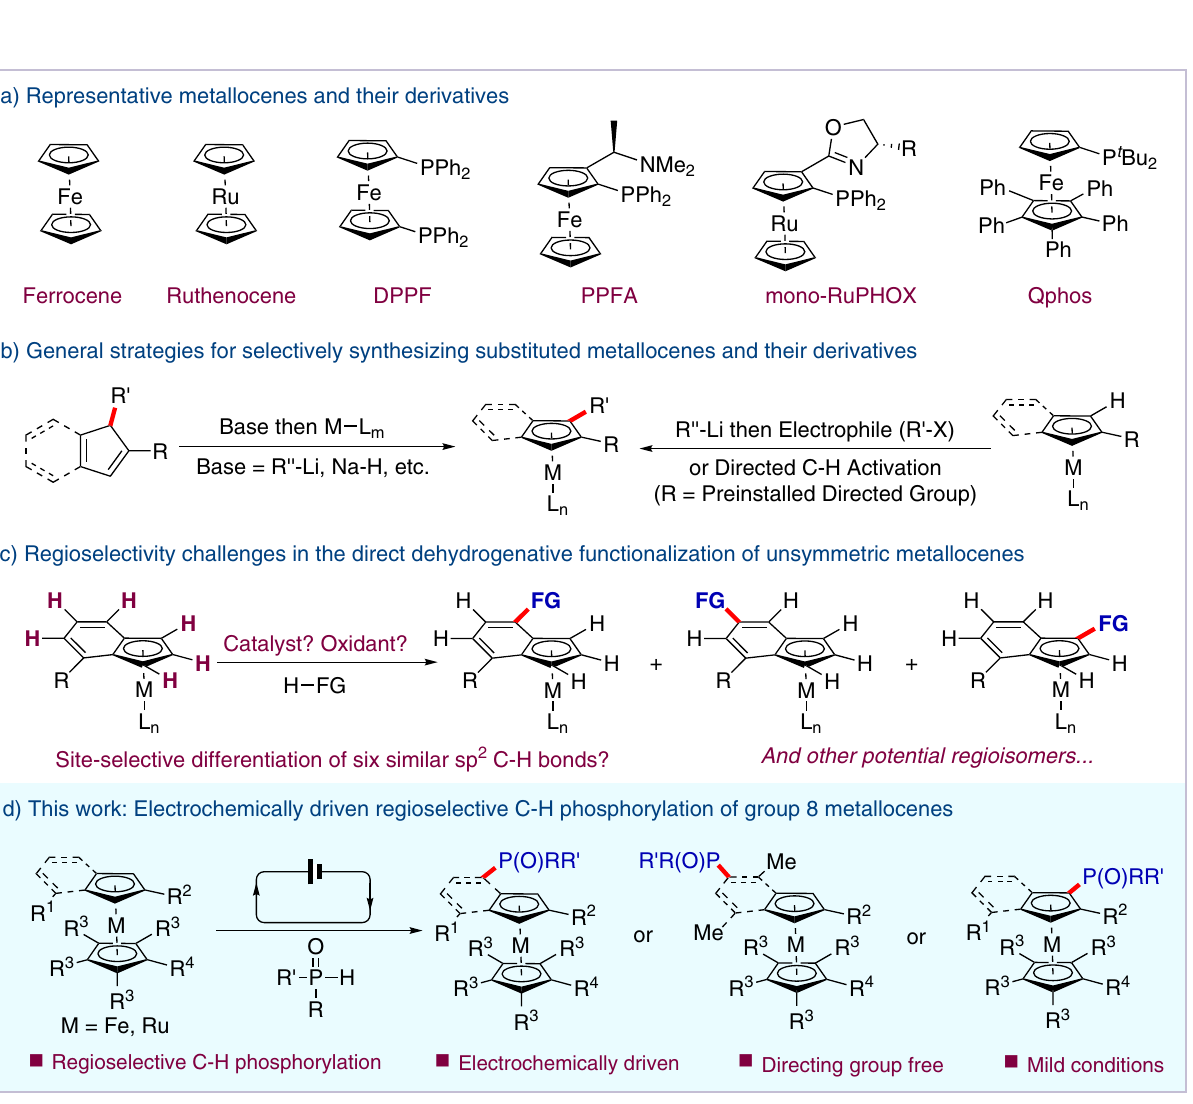
Fig. 1 Synthesis of metallocene phosphine ligands. a Representative metallocenes and their derivatives. b General strategies for synthesizing substituted metallocenes and their derivatives. c Regioselectivity challenges in the direct dehydrogenative functionalization of unsymmetric metallocenes. d This work: Electrochemically driven regioselective C − H phosphorylation of group 8